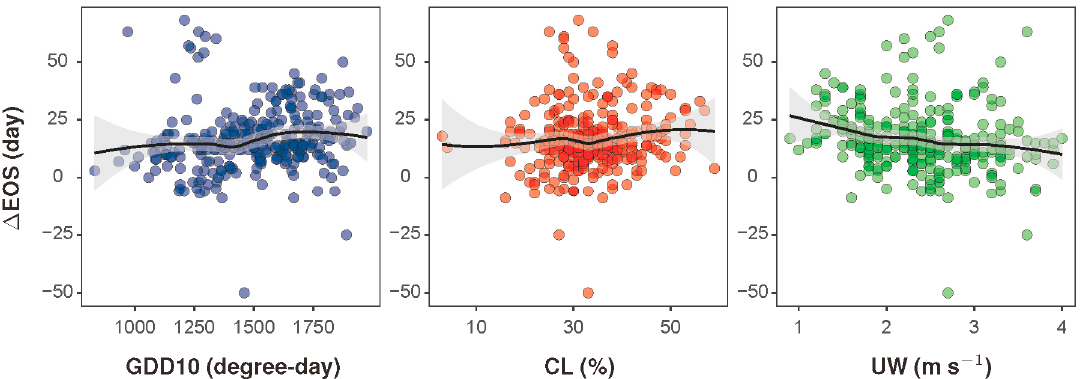
Figure 6. Relationships between the satellite-ground difference in the cropland growing season end ( ∆ EOS) and the major climatic factors, including the growing degree-days at the base temperature of 10 °C (GDD10), the lower cloud cover (CL), and the wind velocity (UW). Black lines represent the best-fit trends based on local polynomial regression.